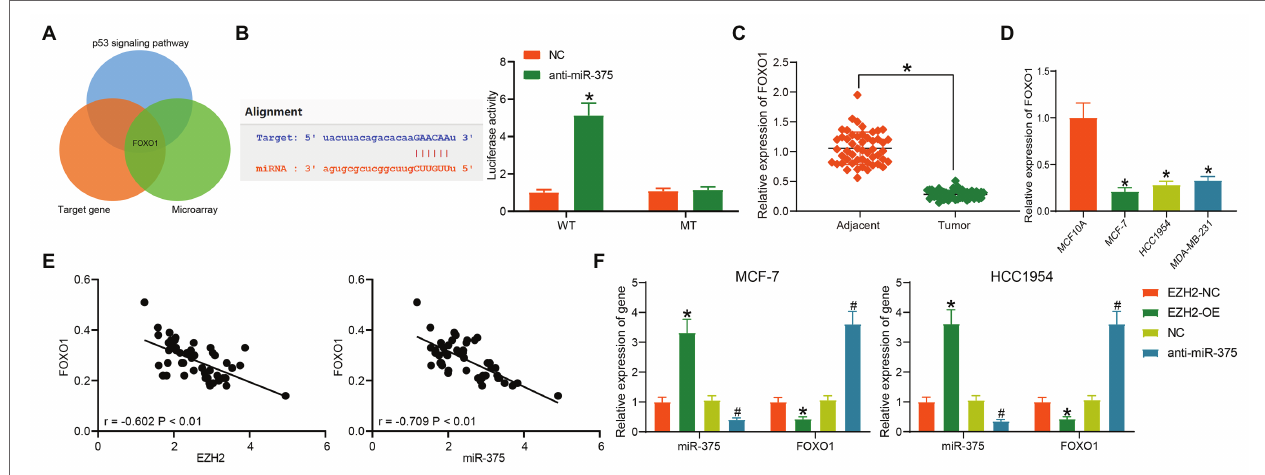
FIGURE 5 | miR-375 directly targets FOXO1. (A) A Venn diagram for the targeting mRNA of miR-375; (B) binding relationship between miR-375 and FOXO1 validated through a dual-luciferase reporter gene assay (* p < 0.05, two-way ANOVA); (C) FOXO1 expression in tumor and normal tissues determined by RT-qPCR (* p < 0.05, paired t test); (D) FOXO1 expression in BC and normal cells detected by RT-qPCR (* p < 0.05, one-way ANOVA); (E) negative correlation between miR-375 and miR-375 and EZH2; (F) expression of miR-375 and FOXO1 in cells in the presence of anti-miR-375 or EZG2-OE determined by RT-qPCR (* # p < 0.05, *EZH2-NC vs. EZH2-OE; #NC vs. anti-miR-375; two-way ANOVA). Data were presented as mean ± SD from three independent